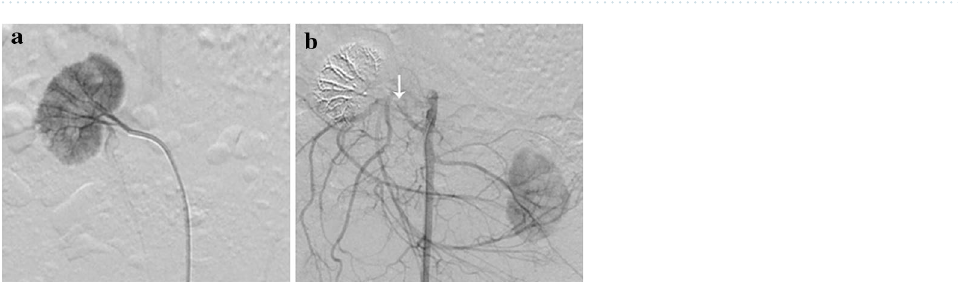
Figure 1. Temperature-sensitive PIB nanogel sol–gel phase ‐ transition behaviors. ( a ) Temperature modulus testing found that the liquid–solid phase changed at 35 °C. ( b ) TEM images show the diameter of the PIB nanogels at 25 °C and 37 °C. ( c ) PIB nanogels were packed in a 2 mm diameter glass ball tube whose lower segment was immersed in a 37 °C constant temperature water bath; the liquid gel underwent phase transformation for a gel solid below the liquid level.